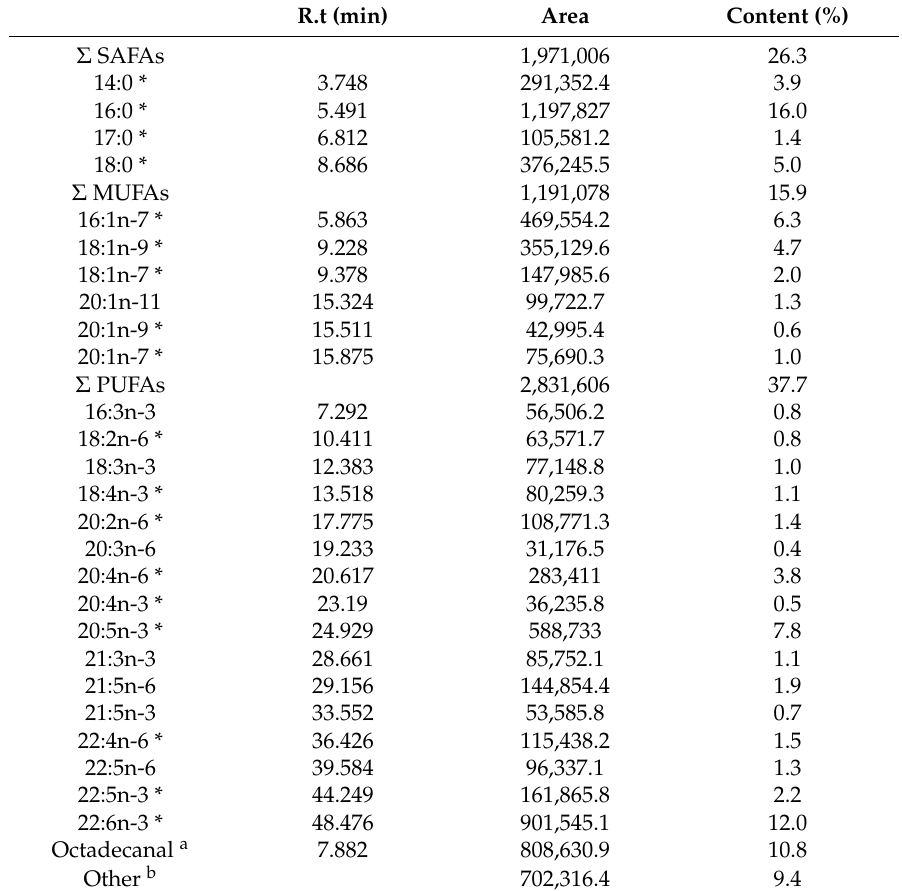
Table 2. Fatty acid composition (% of total) of